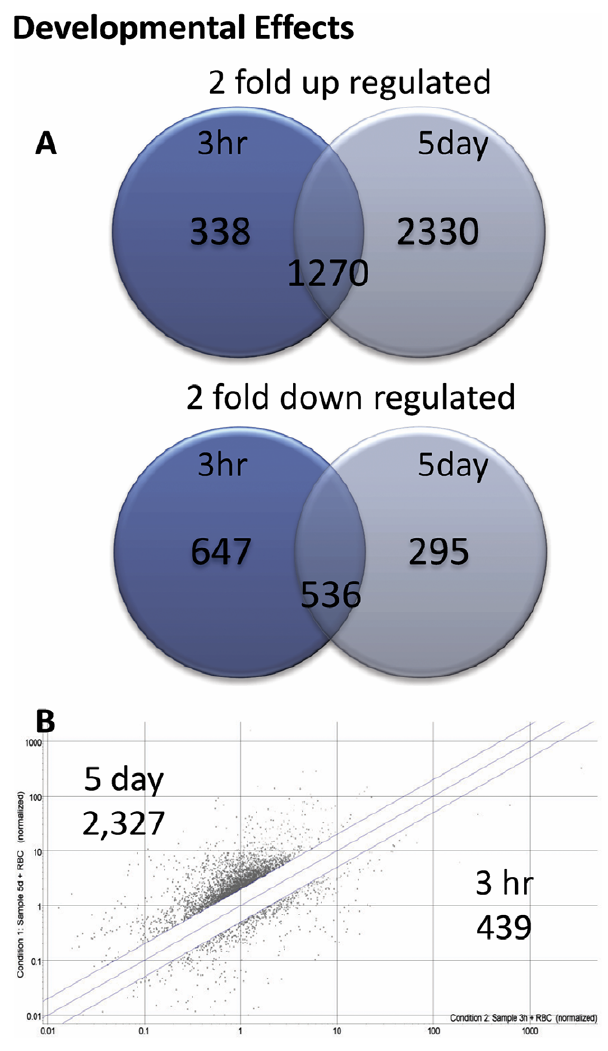
Figure 1. The number of genes differentially expressed between cercariae and 3 h or 5 day cultured S. mansoni schistosomula. (A) The number of genes either up- or down- regulated . 2 fold in 3 h or 5 day schistosomula relative to gene expression in cercariae. Numbers in the overlapping region of the Venn diagram indicate genes that were differentially expressed at 3 h and 5 days. (B) Scatter plot of individual gene signal intensity of 3 h and 5 day schistosomula, with a 2-fold cut off, demonstrating the change in gene expression between the two time points.